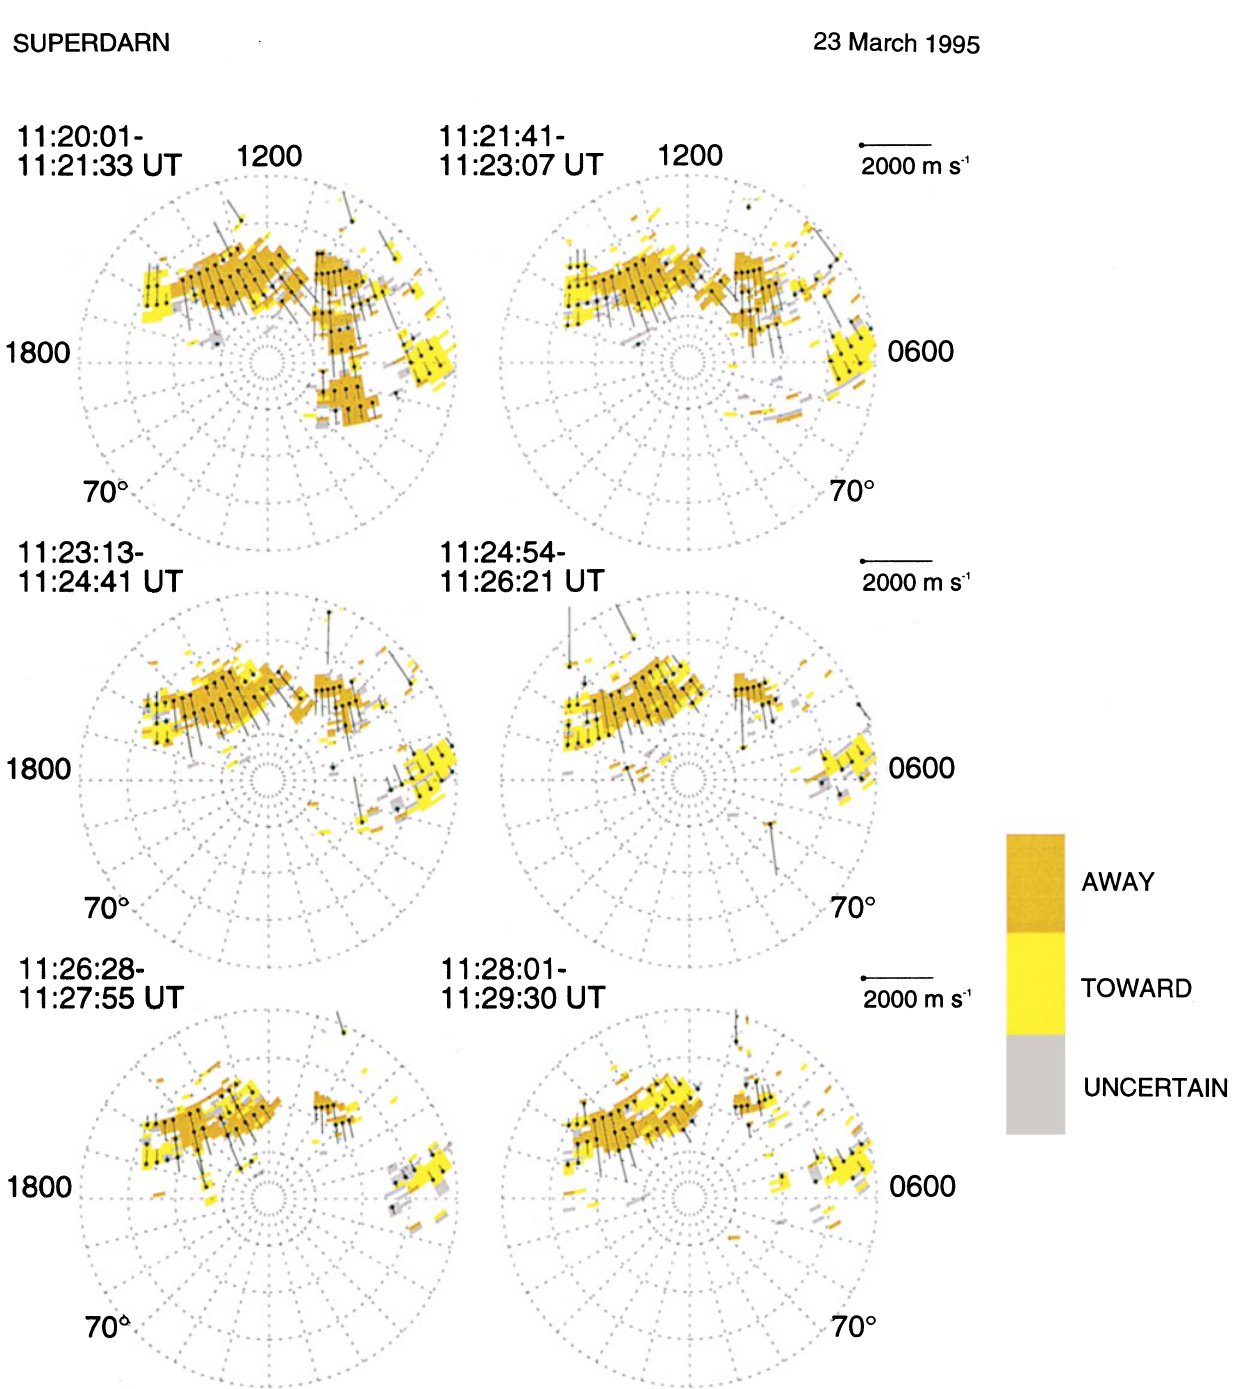
cells indicate areas in which the flow direction toward or away from the radar was uncertain, i.e. for which |velocity|<